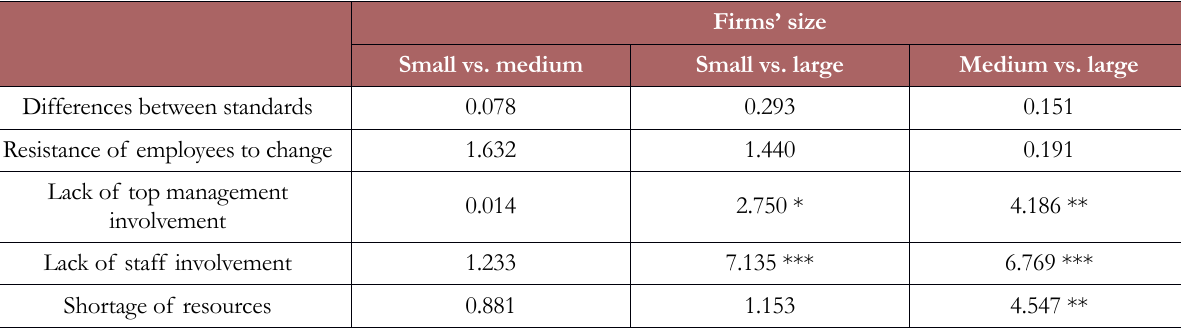
Table 6. Kruskal-Wallis test: Perceived difficulties between firm size